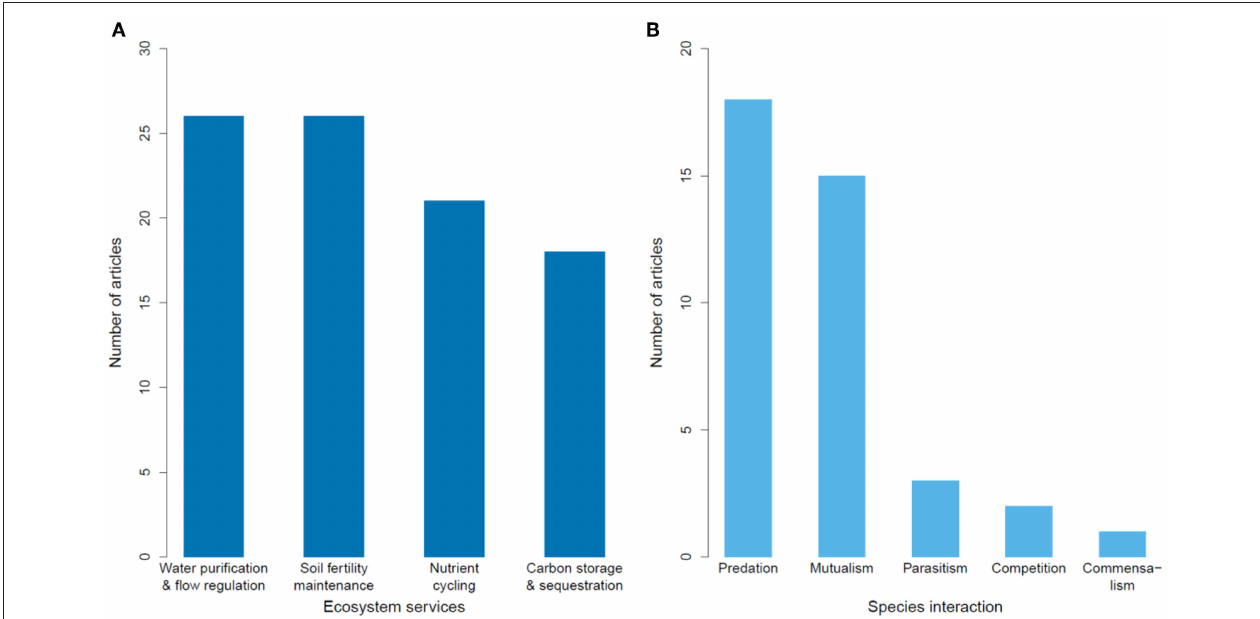
FIGURE 5 | Number of articles published on the impacts of habitat degradation on tropical montane biodiversity studying different types of (A) ecosystem services, and (B) species interactions.